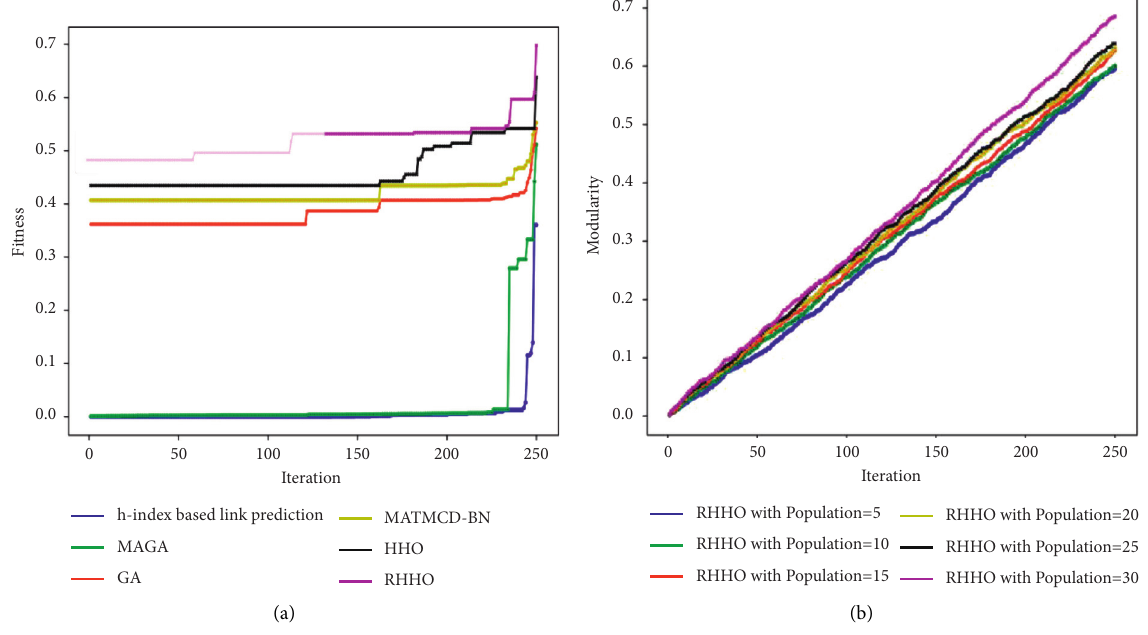
Figure 9: Analysis of methods using the cit-HepTh considering (a) fitness and (b) modularity.